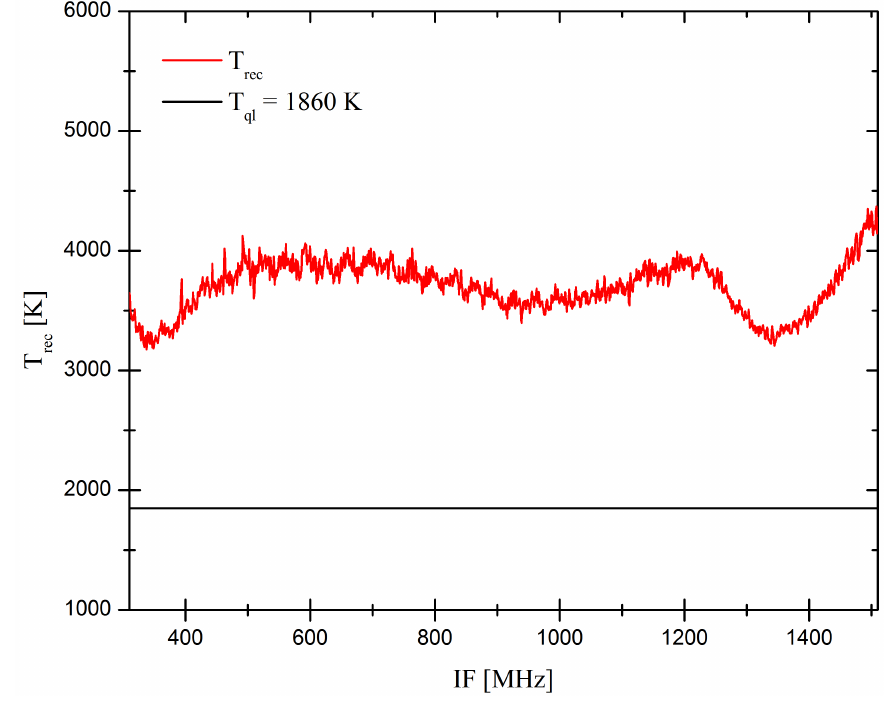
Figure 7. The sensitivity of the instrument from 300 MHz to 1,500 MHz is displayed in terms of the receiver noise temperature, T . The red line displays the measured rec performance, which is within a factor of two of the quantum limit represented by the black line. QCL, quantum cascade